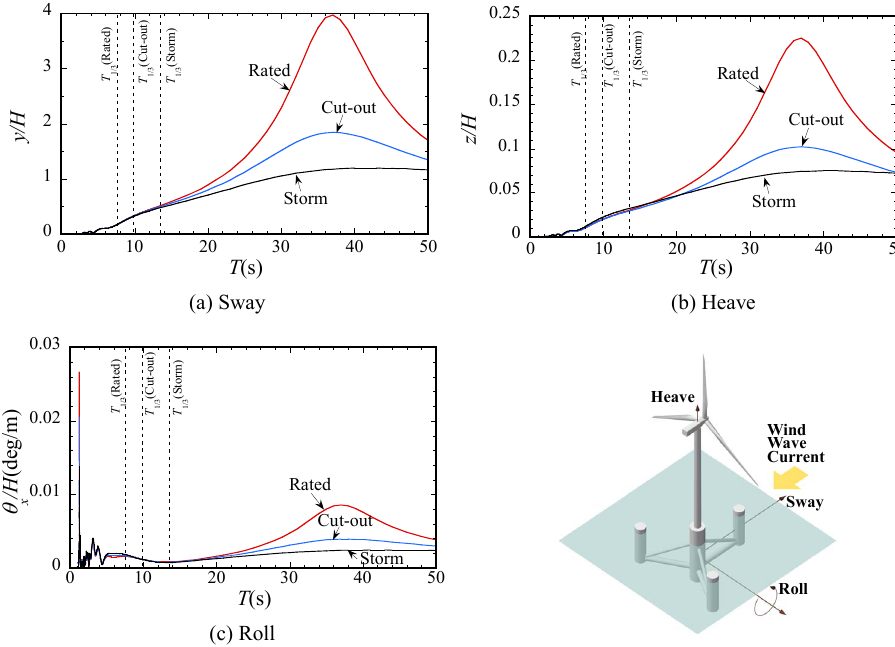
motion of the TLP will be compliant to wave motion. Thus, dynamic tension can also be assumed to be compliant to wave motion. According to the Rayleigh distribution, α = 1.8 corresponds to the ratio of the most frequent value of the maximum value to the significant value during approximately 3 h.